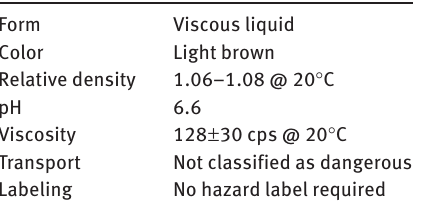
Table 2 Physical properties of poly-carboxylic ether 4.